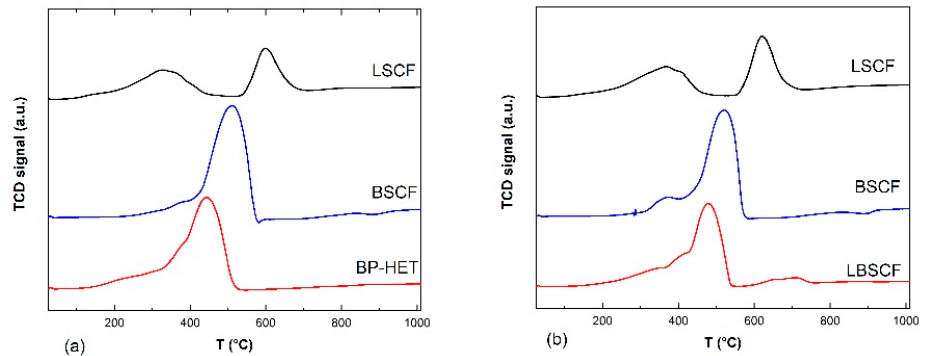
Figure 6. H 2 -TPR profiles of BP-HET, BSCF900 and LSCF900 ( a ) and LBSCF, BSCF1000 and LSCF1000 ( b ) between RT-1000°C .